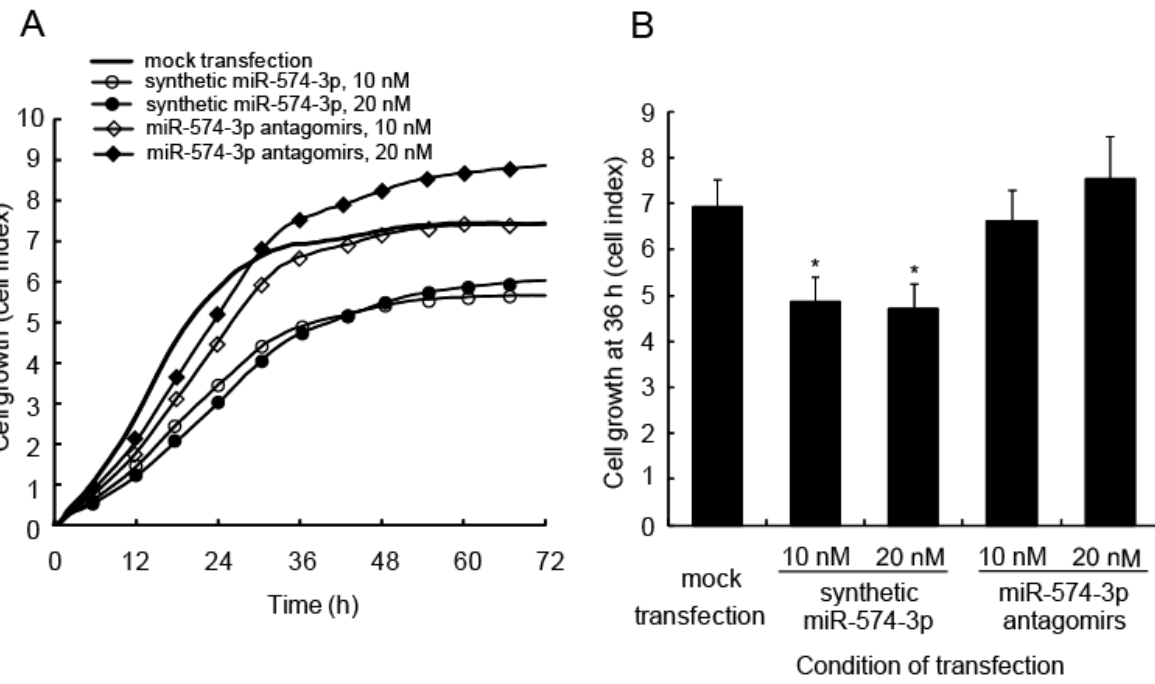
Figure 3. Delay in cell growth caused by overexpression of miR-574-3p in A549 cells. ( A ) A549 cells were transfected with 10 or 20 nM synthetic miR-574-3p or miR-574-3p antagomirs. Cells transfected with the synthetic miR-574-3p or miR-574-3p antagomirs were incubated for 24 h and then re-plated into the wells of a device that allows real-time measurement of cell growth (calculated as the cell index) at 1-h intervals. Each experiment was conducted four times; ( B ) Cell growth was assessed using the cell index at 36 h. * p < 0.05 vs . mock-transfected